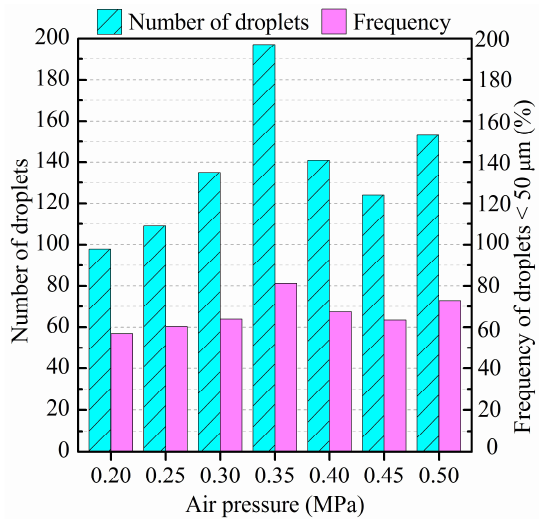
Figure 9. Variation of atomization parameters with air pressure.